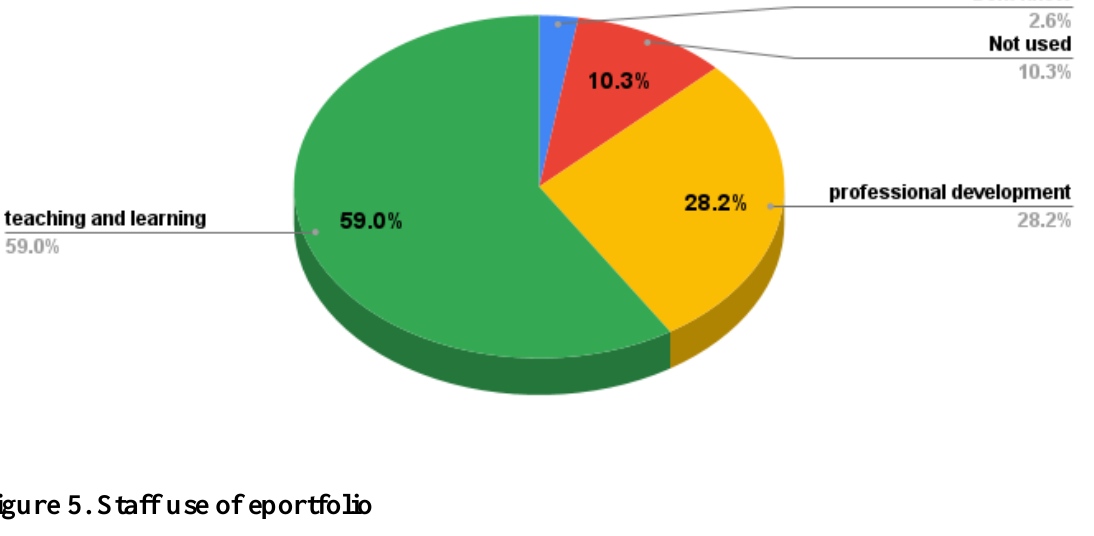
Figure 5. Staff use of eportfolio